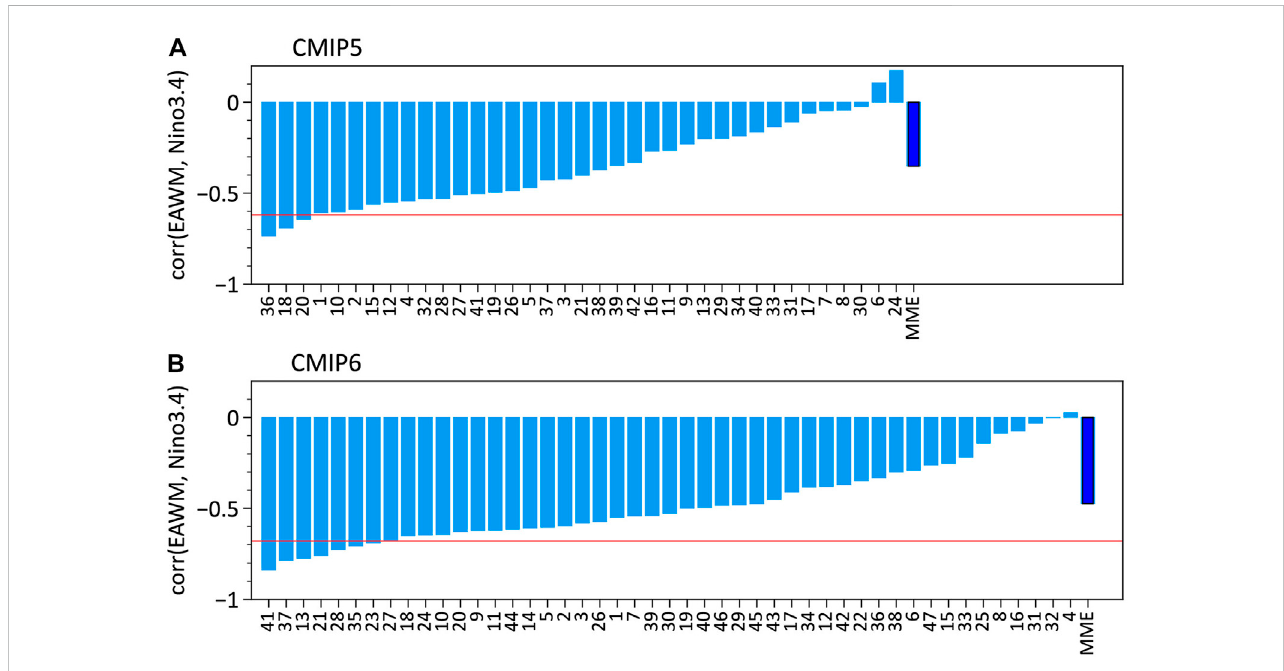
FIGURE 5 Correlation coef fi cients between the winter (Dec-Jan-Feb-averaged) EAWM index and Niño 3.4 index (A) in 37 CMIP5 models during 1979 – 2005; (B) in 47 CMIP6 models during 1979 – 2014. Red lines in (A, B) indicate the corresponding correlation coef fi cients using NCEP2 reanalysis. The list of CMIP5/ 6 models is shown in Table